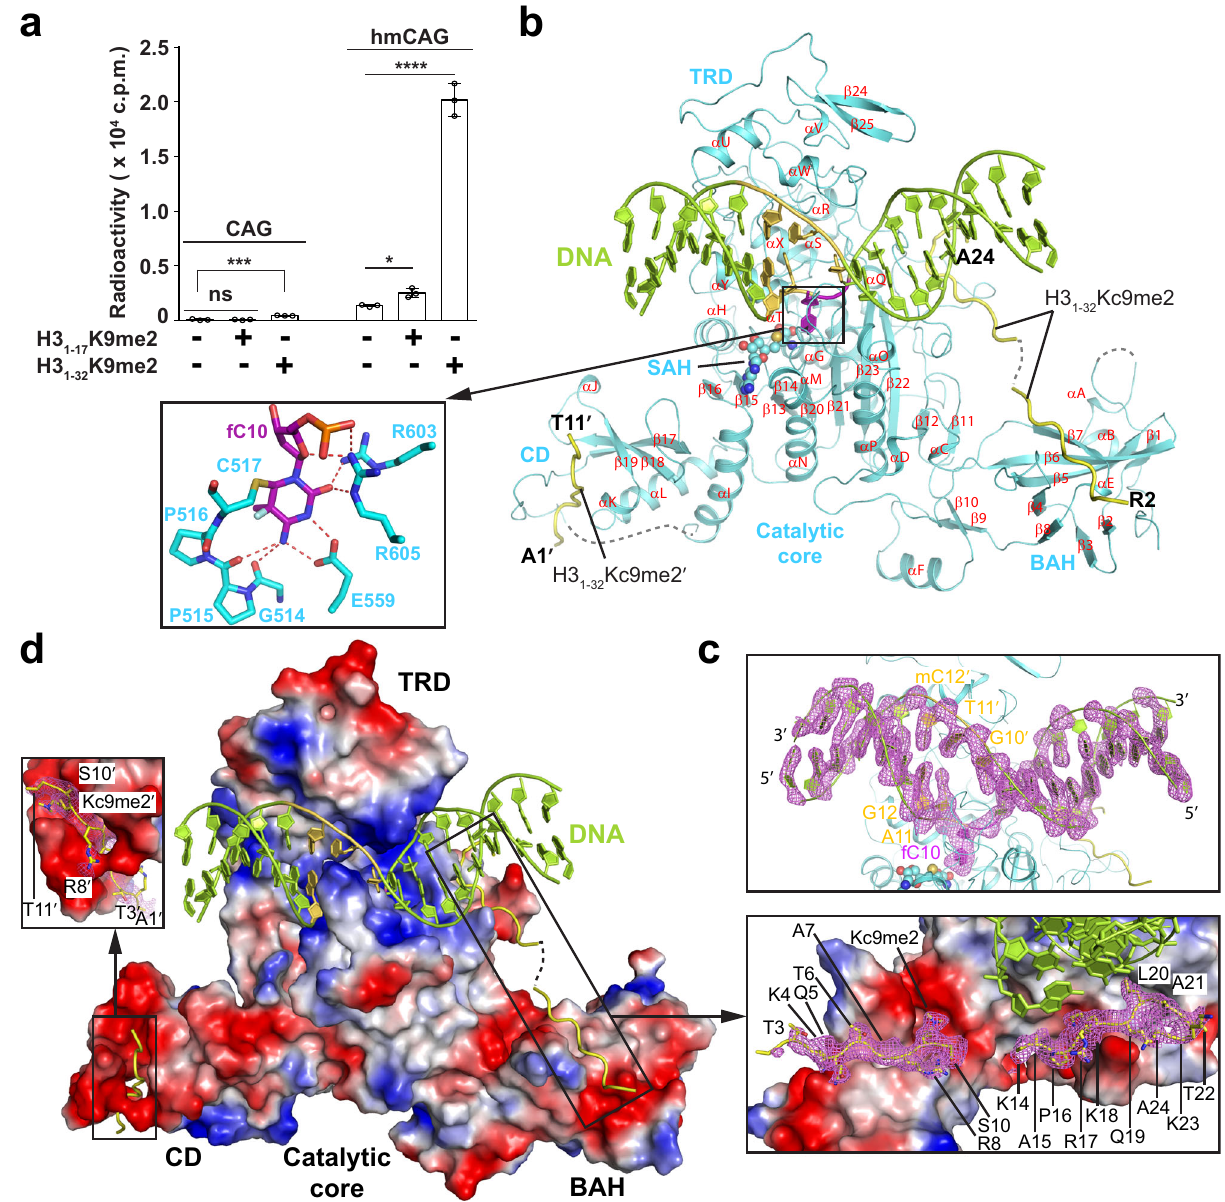
Fig. 1 A structural framework for understanding the H3K9me2-directed CHG methylation maintenance by ZMET2. a In vitro DNA methylation assay of ZMET2 on an 18-mer DNA duplex containing single CAG or hmCAG site, in the presence or absence of histone peptide (H3 1 – 17 K9me2 or H3 1 – 32 K9me2). Data are mean ± s.d. ( n = 3 biological replicates). Statistical analysis of the presence vs absence of peptide conditions used two-tailed Student ’ s t test. ns, not signi fi cant; * p = 0.01; *** p = 0.0008; **** p < 0.0001. b Crystal structure of ZMET2 in complex with an 18-mer hmCAG and the H3 1 – 32 Kc9me2 peptide, with the active site harboring the target cytosine fC10 shown in the expanded view. ZMET2, DNA, and H3 1 – 32 Kc9me2 peptides are colored in aquamarine, lemon, and yellow, respectively. The hmCAG site is colored in purple (for fC10) or yellow-orange. The SAH molecule is shown in sphere representation. The secondary structures of ZMET2 are labeled numerically for helices and alphabetically for β -strands. The disordered regions of ZMET2 and H3 peptides are depicted as dashed lines. c Fo-Fc omit map (violet; 2.0 σ contour) and cartoon representation of the DNA bound to ZMET2, with the nucleotides at the CHG site labeled. d Electrostatic surface view of ZMET2 bound to DNA and H3 1 – 32 K9me2 peptides, with the Fo-Fc omit maps (violet; 2 σ contour) of the H3 peptides (residues labeled; stick representation) are highlighted in the expanded views. The same color scheme in b is applied to all the subsequent fi gures unless indicated otherwise. Source data are provided as a Source Data fi and Supplementary Fig. 2e), where it is anchored through the two sides of the catalytic core fl anked by a CD domain and a covalent linkage with C517 and hydrogen-bonding interactions BAH domain, respectively (Fig. 1b, d). The DNA molecule is with G514, P515, E559, R603, and R605 (expanded view in embedded in the cleft between the catalytic core and TRD, Fig. 1b). There are two H3Kc9me2 peptides in each complex, with resulting in a buried surface area of ~1750 Å 2 (Fig. 1d). Notably, the target 5fC (fC10) breaks away from its Watson-Crick pair one associated with the CD and the other associated with both Gua10 ′ ( ′ denotes the base on the complementary strand) and BAH and MTase (Fig. 1b). Residues A1-T11 were traceable for approaches the SAH molecule in the active site of ZMET2 (Fig. 1b the one bound to the CD, whereas a longer fragment (residues